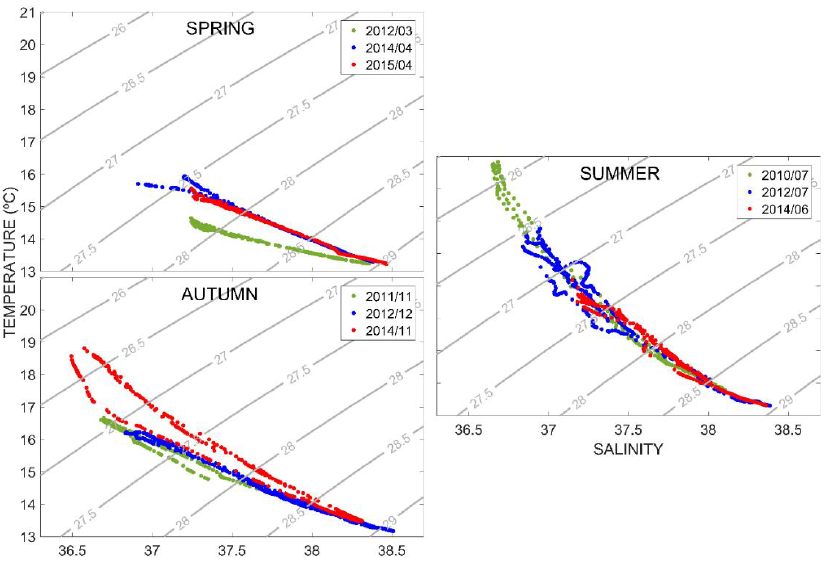
Figure 3. Temperature-salinity plots obtained during the different research surveys. The data are grouped according to three seasonal periods: spring ( top left ), summer ( middle ), and autumn ( bottom left